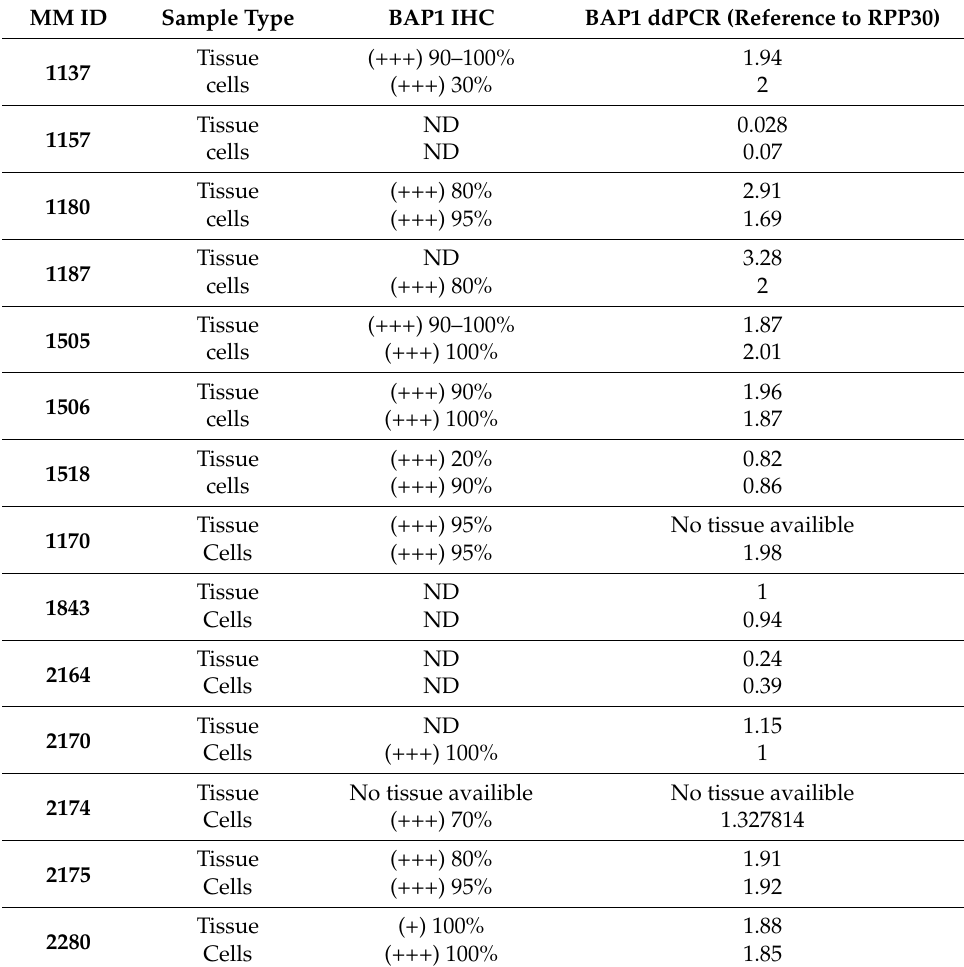
Table 2. Concordance of BAP1 IHC and ddPCR